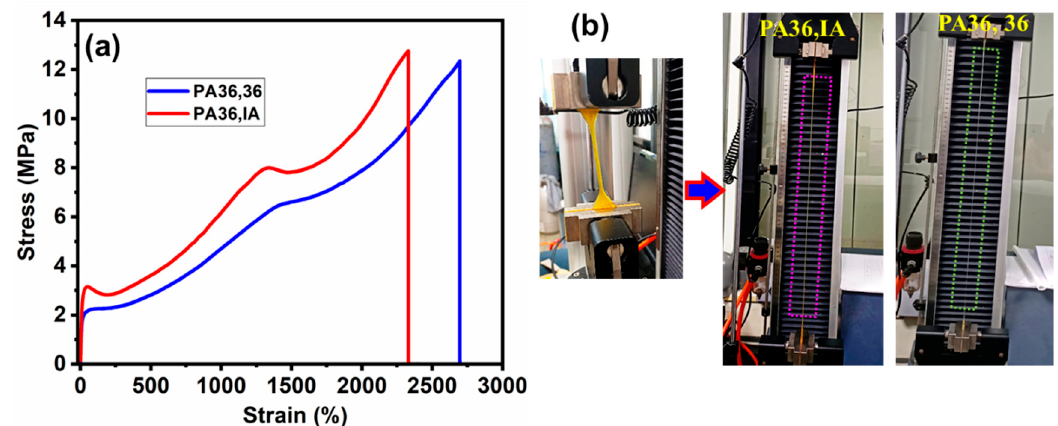
Figure 6. ( a ) Stress–strain curves of PAs and ( b ) stretching photographic images of dumb ‐ bell ‐ shaped PAs.